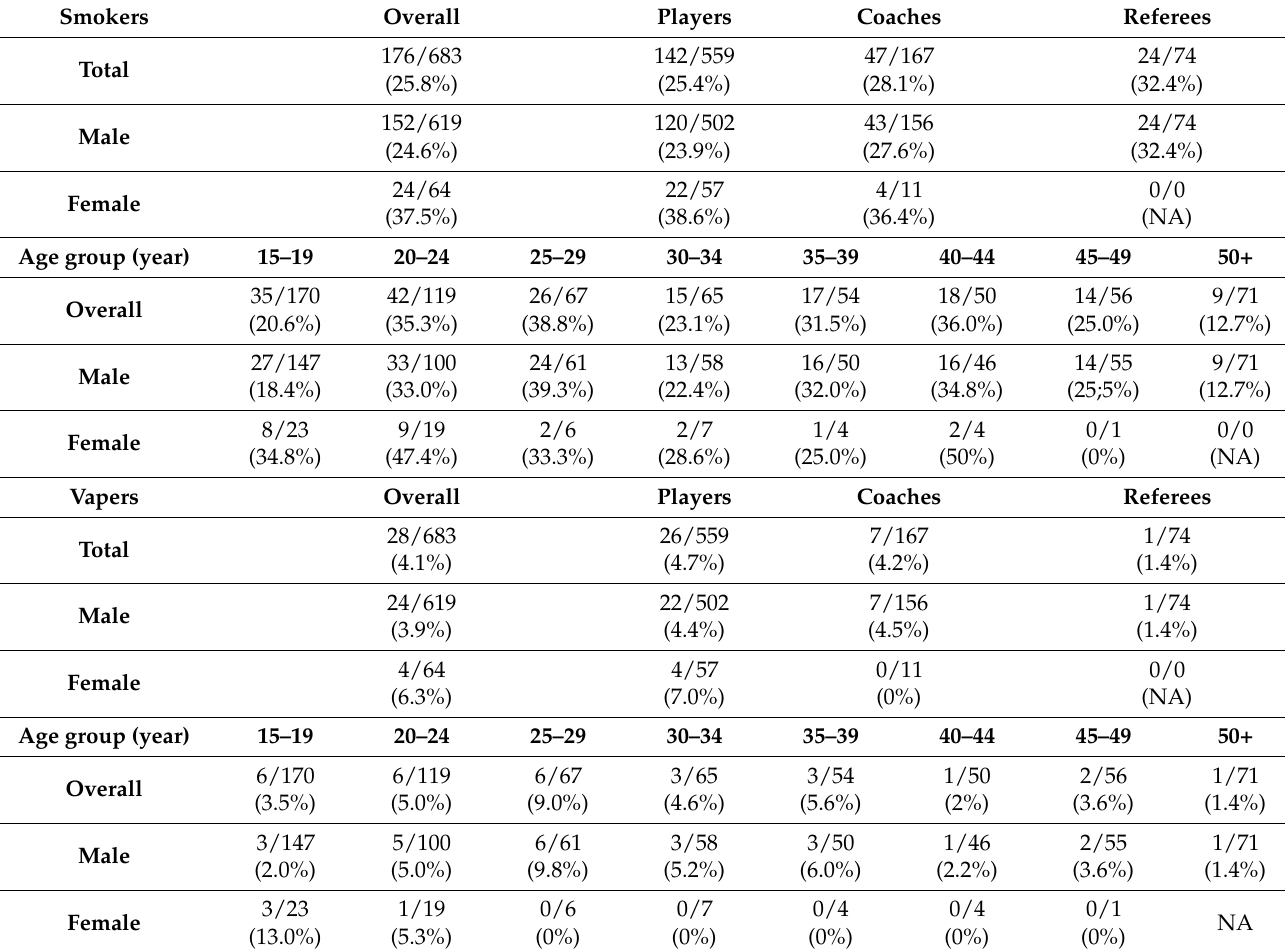
Table 2. Characteristics of smokers (upper part) and vapers (lower part) in the whole population and according to the type of participant { n (%)}. Bold and shading: categories and age groups. NA: not